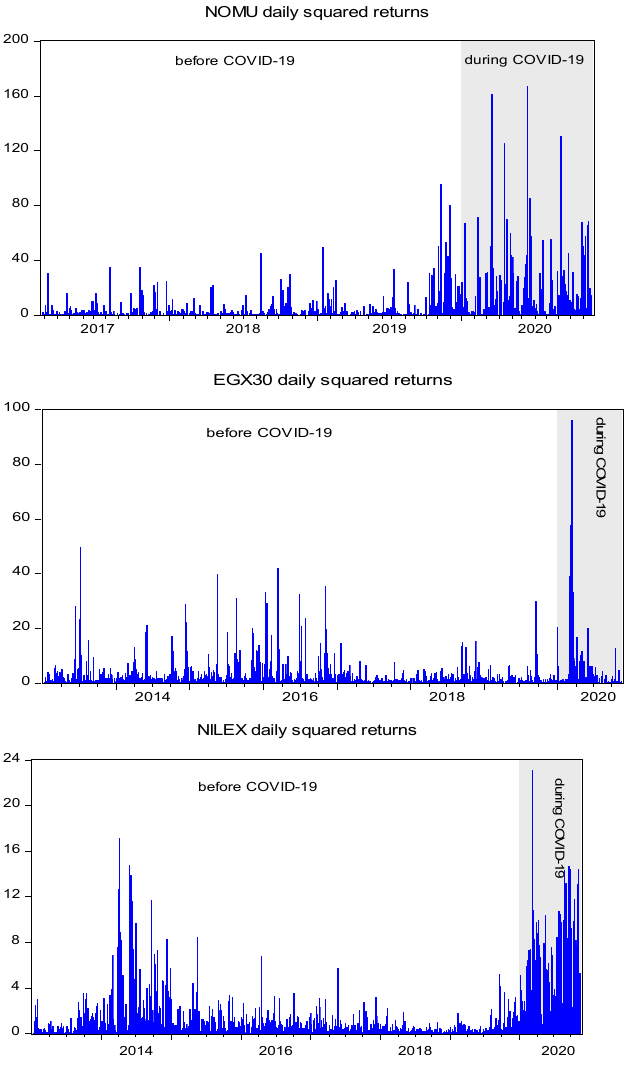
Figure 2. Squared returns of the main and SME stock